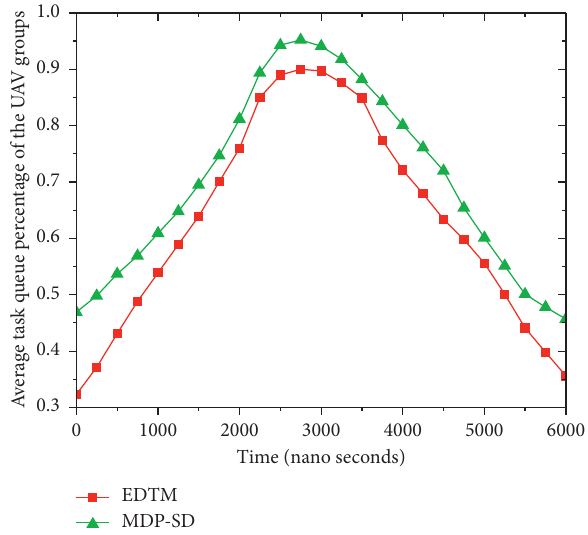
Figure 14: The comparison of average task queue percentage of the UAV groups between the proposed EDTM algorithm and the MDP-SD algorithm. Table 4: The performance comparison.